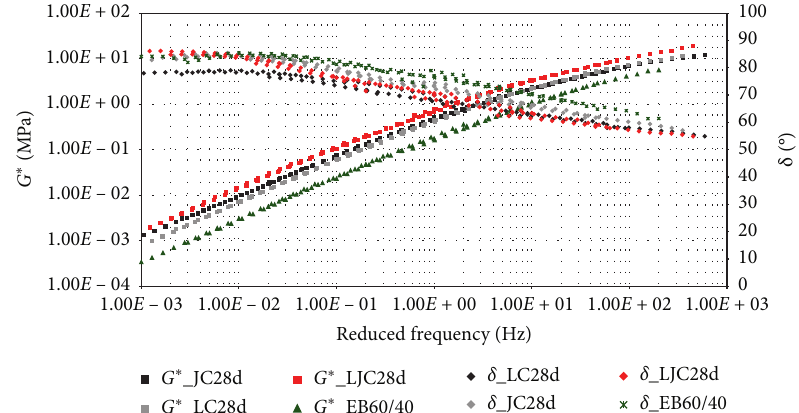
Figure 10: Master curves of the cold mastics subsequent to curing time, after being kept in the oven for three days at 60 ° C and at room temperature (25 ° C) for 25 days.